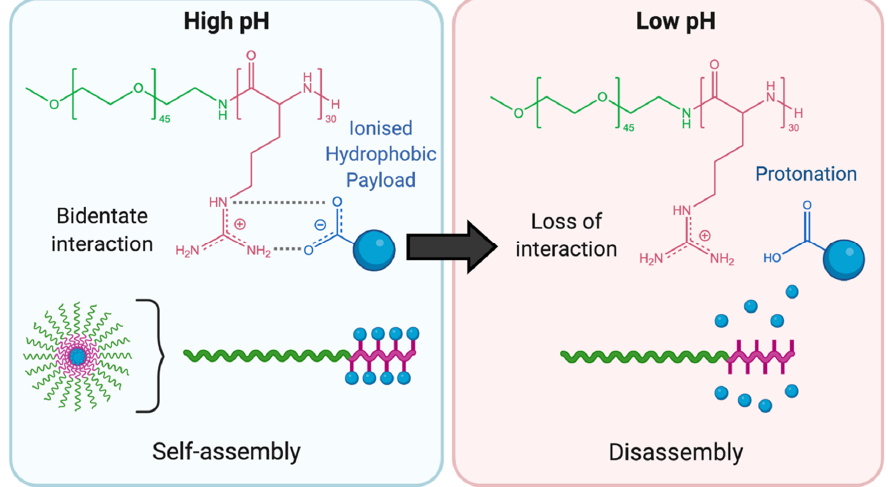
Figure 6. Schematic illustration of the bidentate interactions between the guanidinium moiety of PEG- b -poly( L -arginine) (pink) and the carboxylate group of the encapsulated hydrophobic PEG- b -poly(L-arginine) (pink) and the carboxylate group of the encapsulated hydrophobic payload payload (blue) reported by Praveen et al. (adapted from [82] ). (blue) reported by Praveen et al. (adapted from